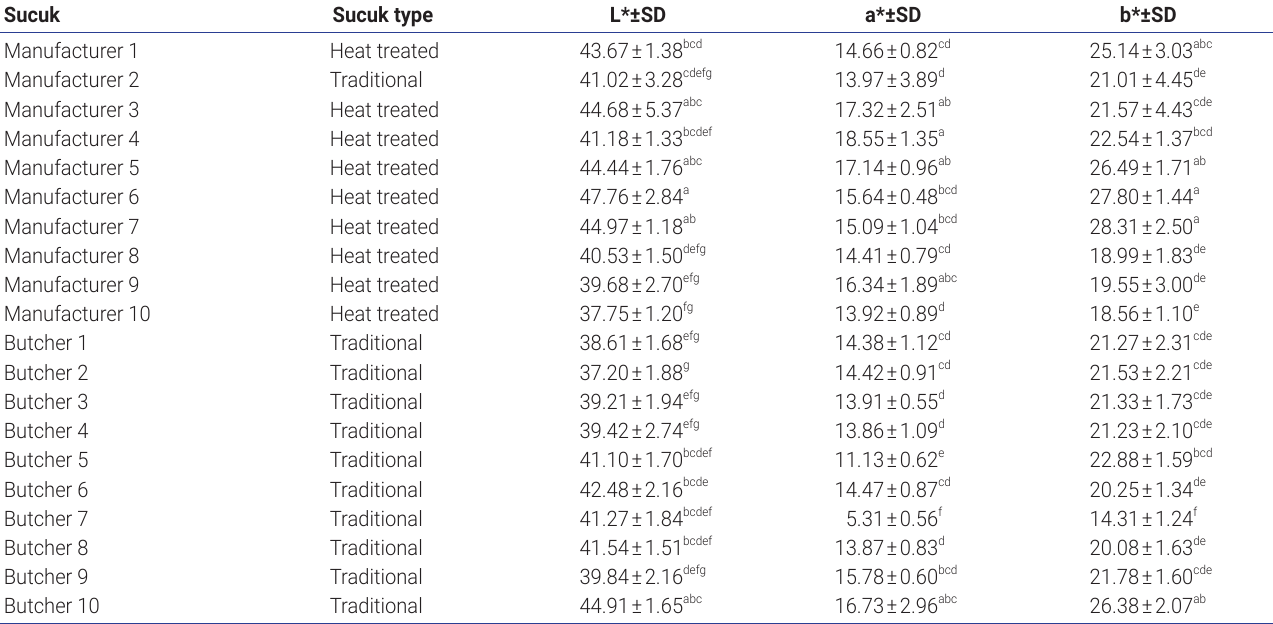
Table 4. Mean outer surface L*, a*, b* values of a total of 60 sucuk samples Sucuk